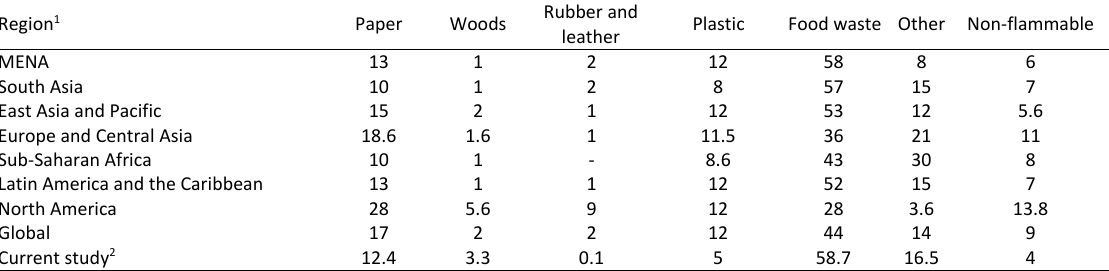
Table 2: The mean average physical compositions of MSW in different regions (dry base wt %) Region 1